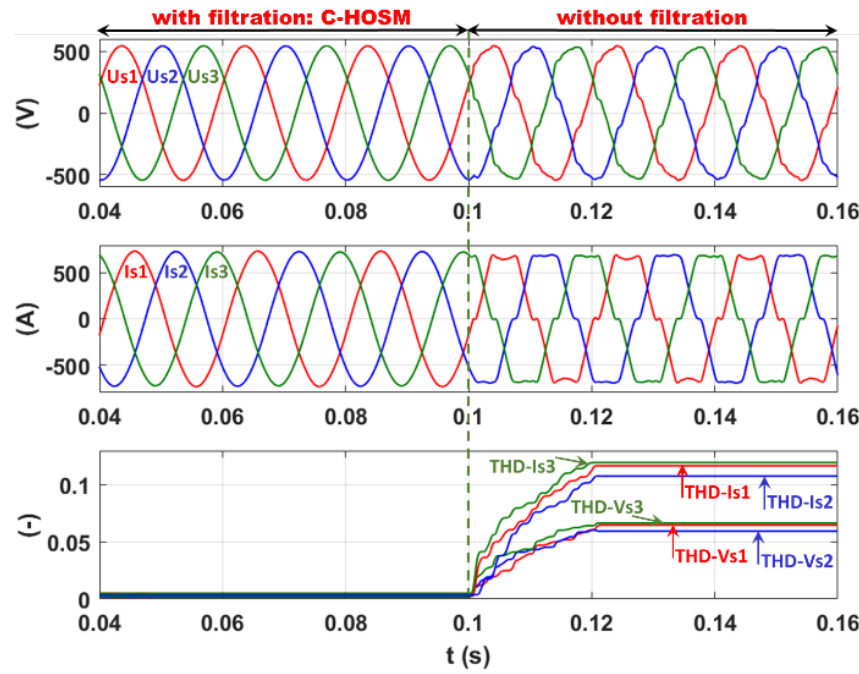
Figure 19. Current filtration: C-HOSM controller.